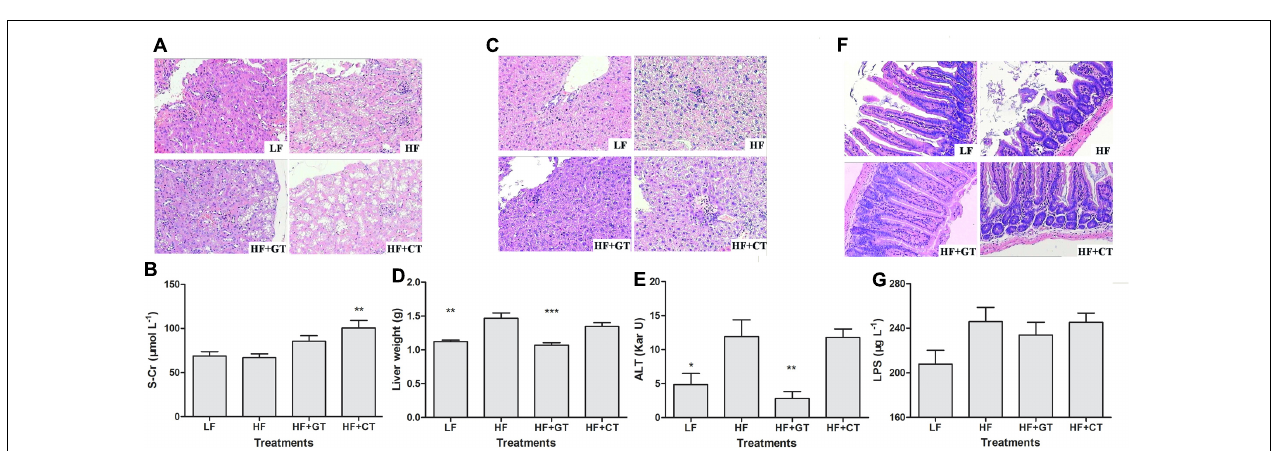
FIGURE 2 | Changes of lipid metabolism in C57BL/6J mice. Body weight of C57BL/6J mice in different groups (A) . C. gloeosporioides -contaminated hindered the benefits of green tea on the increase of INS (B) and decrease of TG (C) and FFA (D) . Data were compared with HF group. Mean ± SEM. ∗ P < 0.05; ∗∗ P < 0.01; and ∗∗∗ P < 0.001.